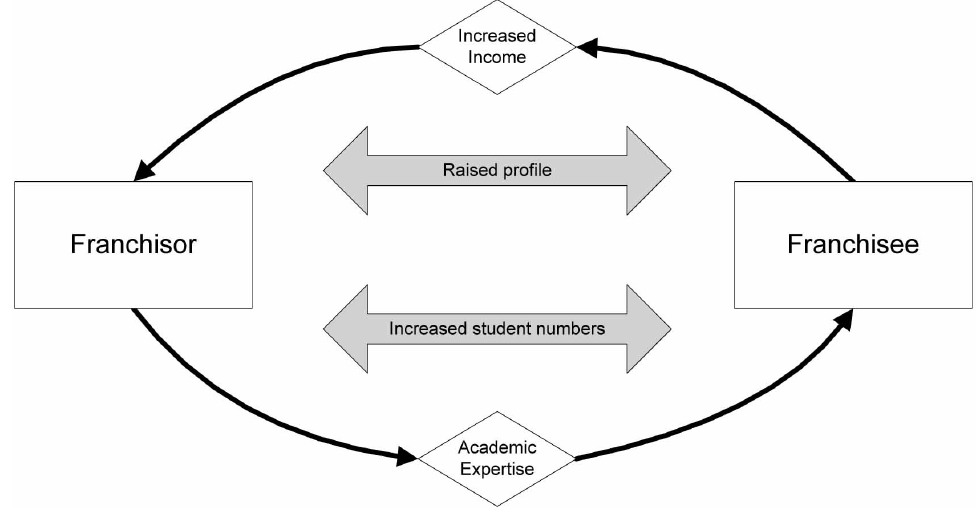
Figure 1: Expectations of benefit received in successful academic